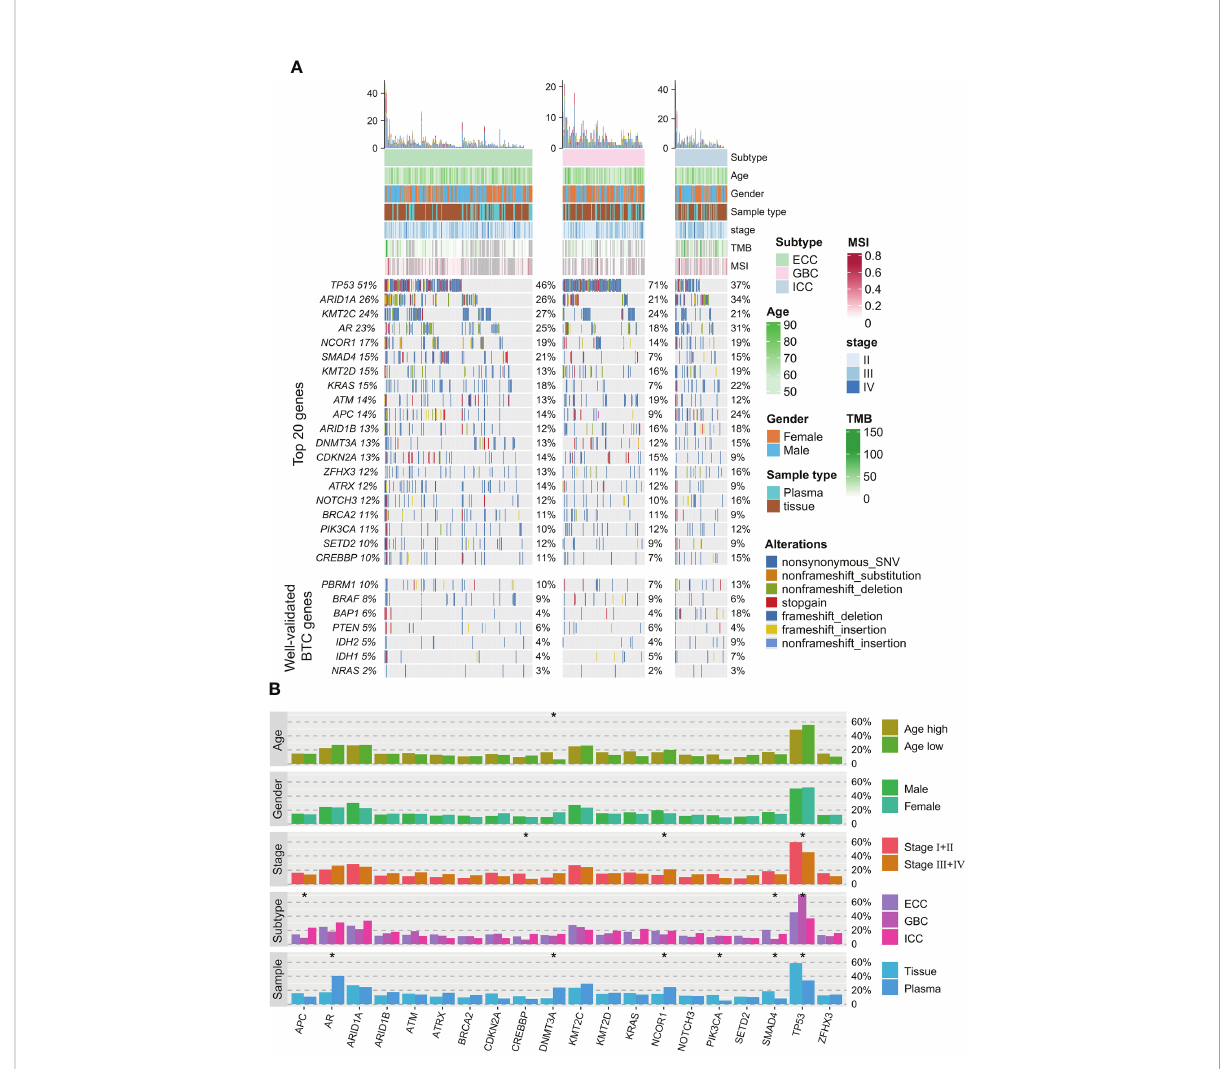
FIGURE 1 Somatic alteration pro fi le of 382 BTC patients. (A) Mutation pro fi les of frequently mutated and well-validated mutated BTC-related genes. Relevant clinicopathological characteristics of 382 patients are shown on the top, total mutation frequencies in the cohort are shown on the left, and mutation frequencies in each histological subtype are shown on the right. (B) Correlations between somatic alterations and clinical phenotypes (age, gender, stage, histological subtype, and sample type) in the entire cohort. * p < 0.05. BTC, biliary tract